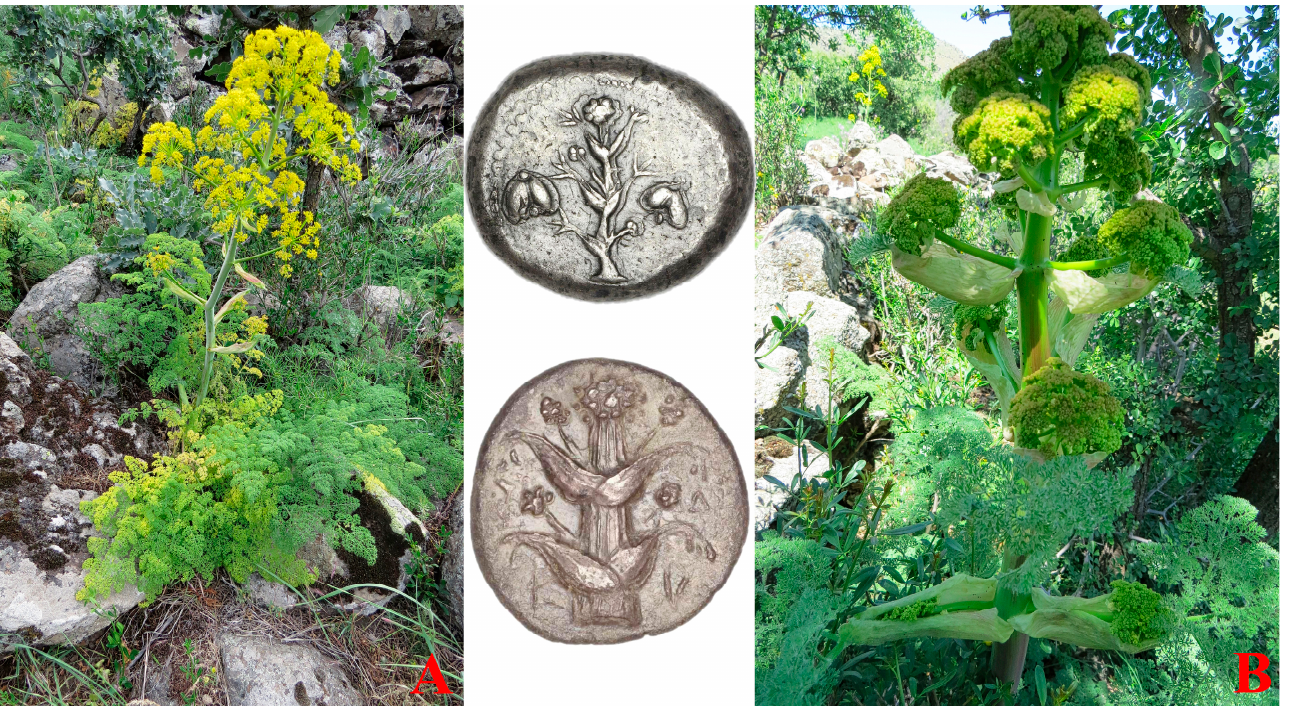
Figure 1. ( A ) The general view of Ferula drudeana is similar to the numismatic silphion plant figures on the early period Cyrenaic coins (upper coin figure). ( B ) The numismatic figures on the later period Cyrenaic coins (lower coin figure) resemble the developing premature flowering stem of F. drudeana . Copyrights of coin figures: Trustees of the British Museum.